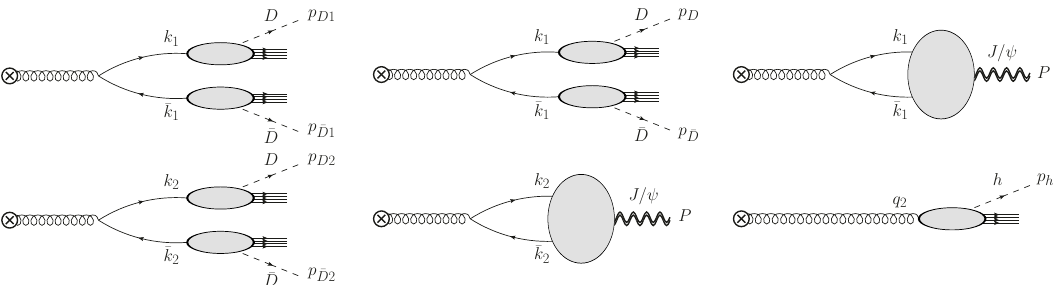
Figure 8 . A few examples of how the partonic cross sections calculated in this paper can hadronize into the heavy (cid:13)avor sector. The partonic ( c (cid:22) c ) ( c (cid:22) c ) cross section could hadronize into the open heavy (cid:13)avor sector such as ( D (cid:22) D ) ( D (cid:22) D ) (left panel, eq. (5.2)) or may include heavy quarkonia such as ( D (cid:22) D ) ( J= ) (center panel, eq. (5.6)). The partonic ( c (cid:22) c ) G cross section could hadronize similarly, but include a light hadron h produced by the gluon, as in ( J= ) h (right panel, eq. (5.7)). (cid:22) 2 ( x; x (cid:0) ) = (cid:22) 2 ( x ) (cid:14) ( x (cid:0) ), so that the projectile is in(cid:12)nitely Lorentz-contracted into a